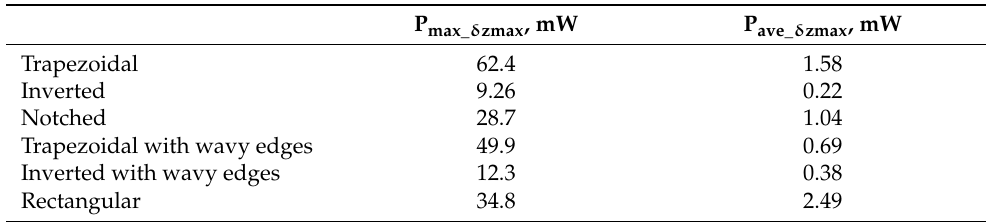
Table 9. Maximal and average power outputs achievable by the optimized PEHs at the maximal allowable initial free-end displacements δ zmax , as determined in Section 5. P max_ δ zmax , mW P ave_ δ zmax ,